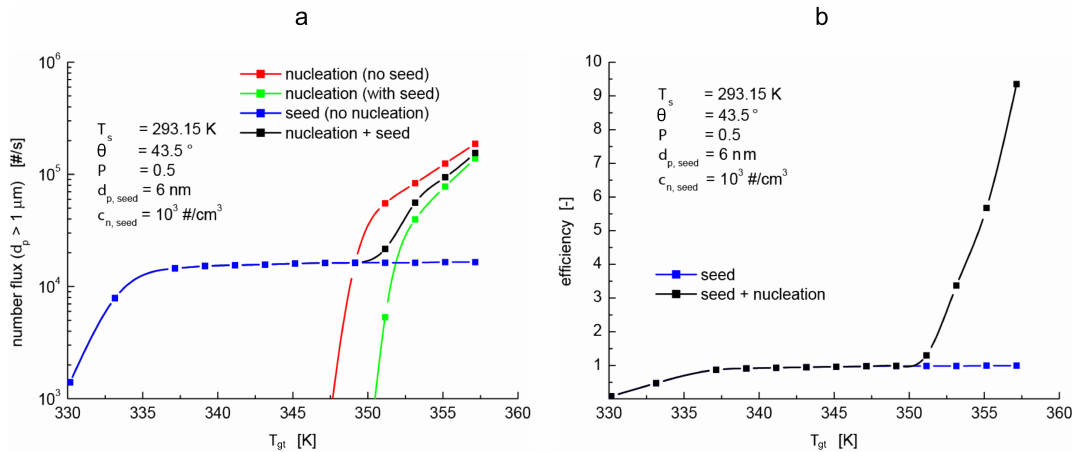
Fig. 7. Modelled particle number flux at the growth tube outlet (a) , and counting efficiency as function of growth tube temperature (b) . time) out of the growth tube (Fig. 7a), and the corresponding CPC counting efficiency as function of growth tube temper- ature (Fig.